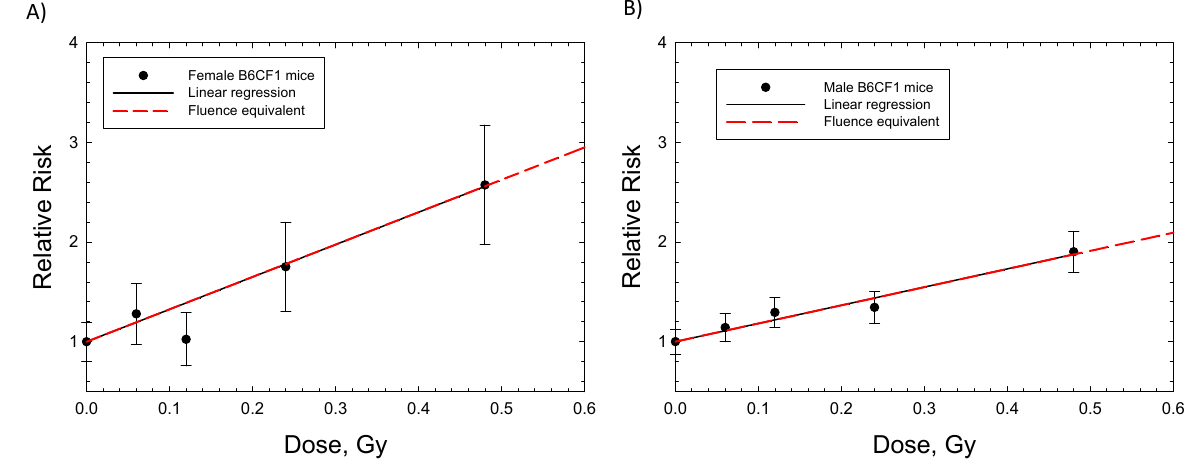
Figure 3. Linear dose responses for relative risk of lung adenocarcinomas in female and male B6CF1 mice exposed to daily fractions of fission neutrons [7]. ( A ) Female B6CF1mice, ( B ) Male B6CF1 mice. Symbols are experimental data with standard errors. Solid (black) line is linear regression and dashed red line is the fluence base result after integrating over charged particles produced by